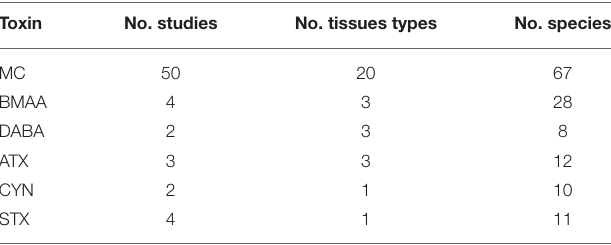
and fish species sampled for each